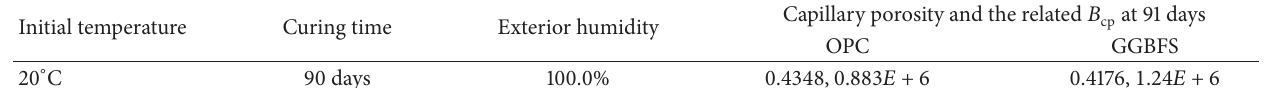
Table 4: Input and boundary conditions for water permeability.